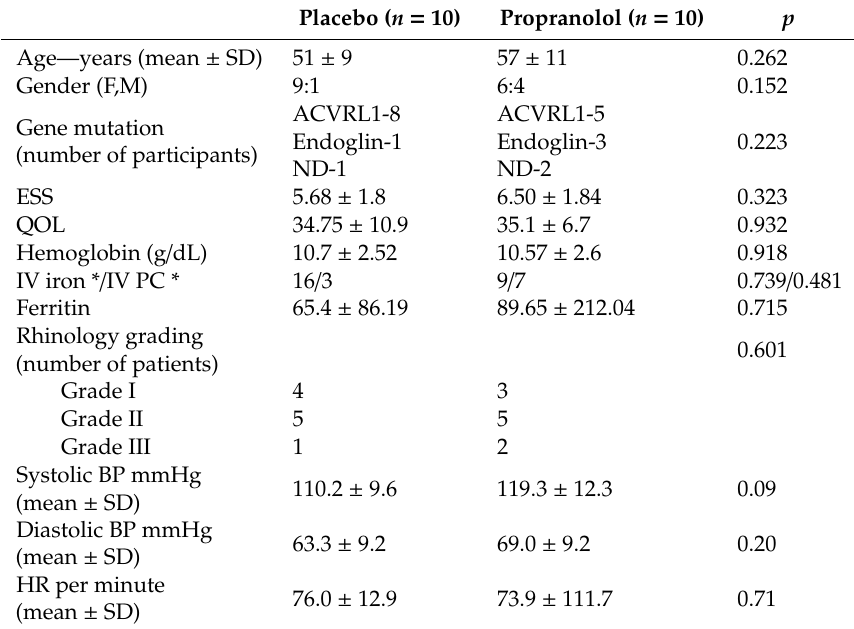
Table 2. Baseline characteristics.